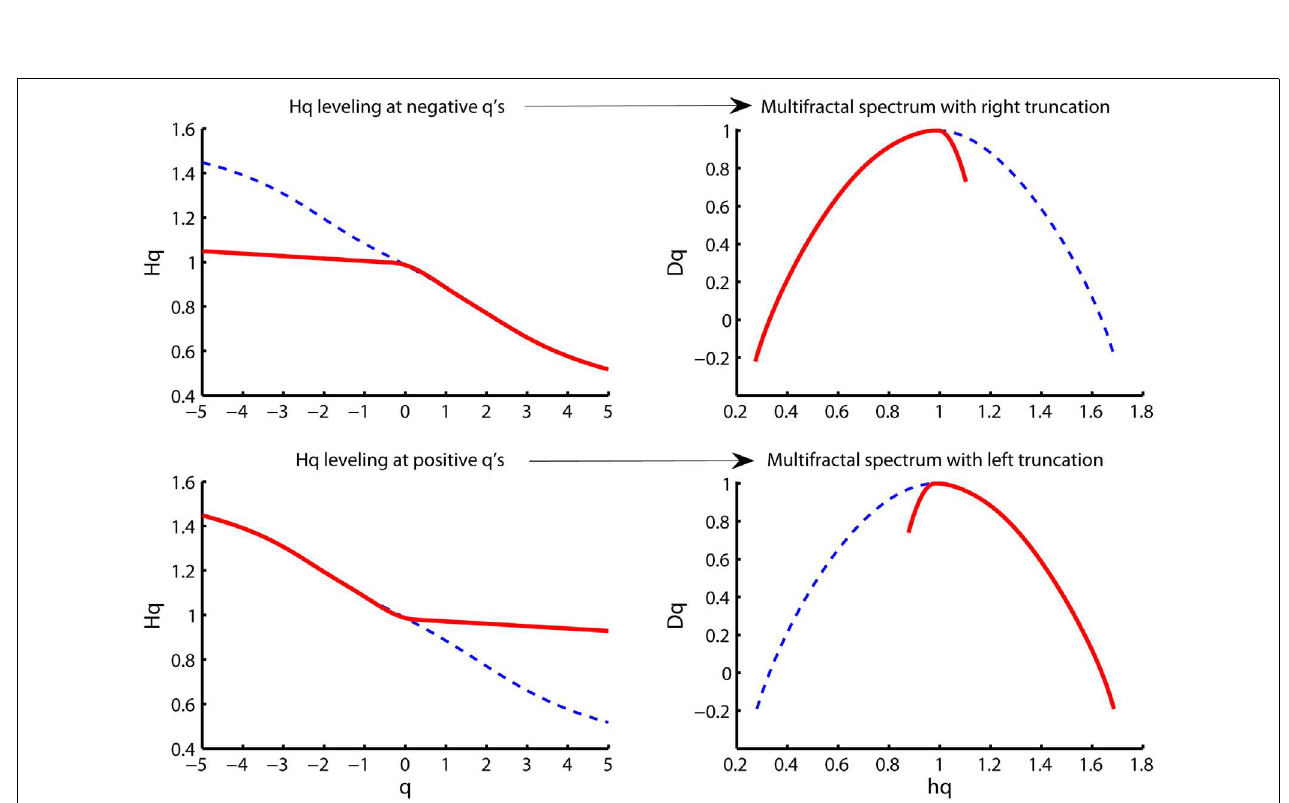
FIGURE 10 | Illustration of a continuum of multifractal time series with the same q -order Hurst exponent for q = 2 but with different multifractal spectrum width [compare vertical axis of the (A) and the